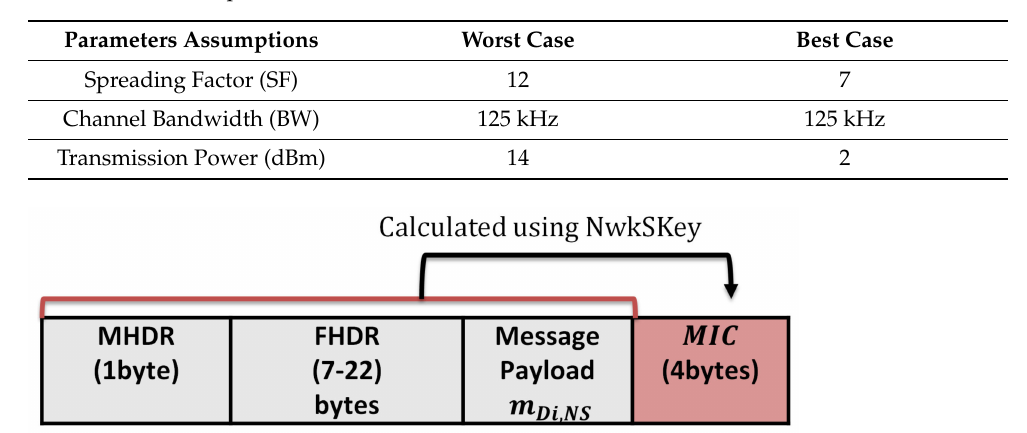
Table 7. LoRaWAN paramaters.